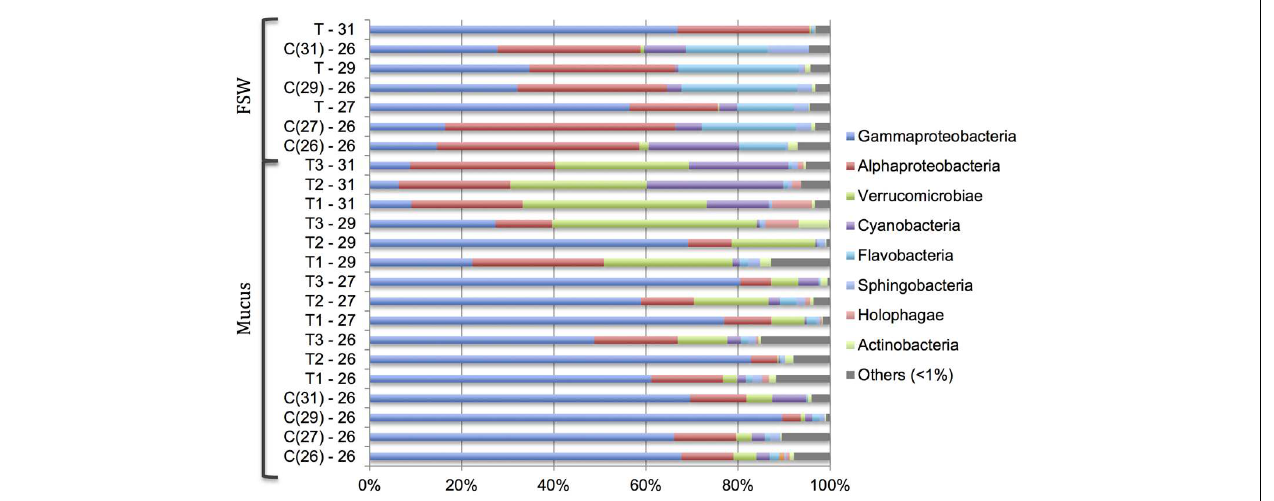
FIGURE 3 | Changes in relative abundance of bacterial community at the class level in the Acropora muricata coral mucus (Mucus) and filtered seawater (FSW) from 26 to 31 ◦ C. Control tanks (C) and treatment tanks (T) and numbers represents the respective temperatures. Numbers in the ( ) in the control samples (C) represent the respective treatment temperature. For example, C(31) – 26 represents control sample at 26 ◦ C when the temperature in the treatment tanks were 31 ◦ C.